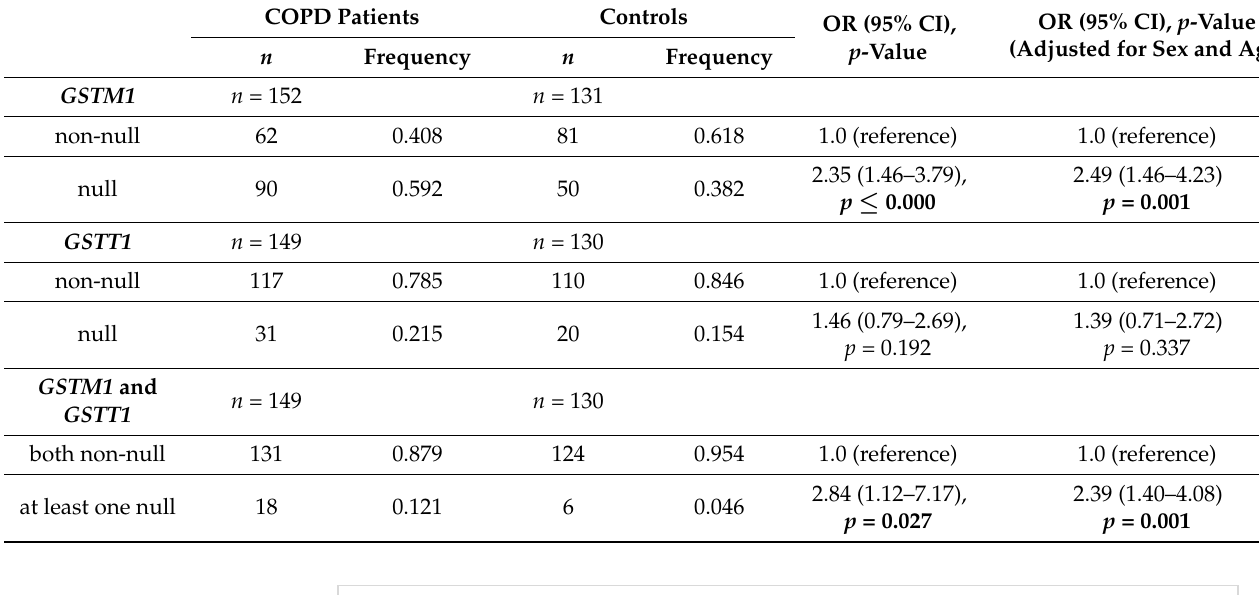
Table 3. Genotype of GSTM1 and GSTT1 gene polymorphism in patients with COPD and controls.